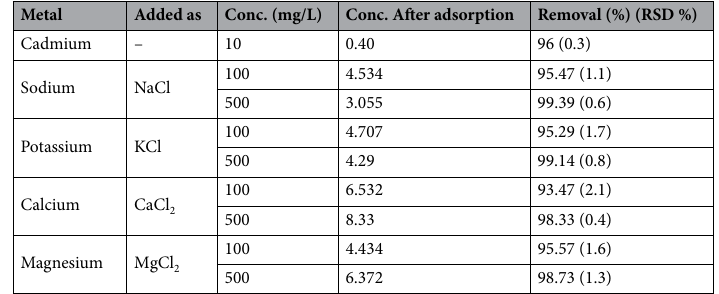
Table 8. Effect of matrix ions on the removal of cadmium ions in the column.